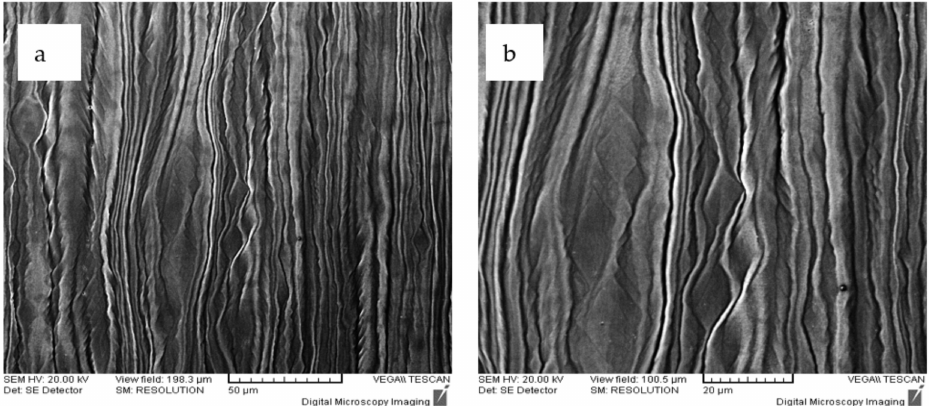
Figure 8. SEM microstructure of the Ti29.3Nb13.6Zr1.9Fe alloy processed at two ( a , b ) differ- ent magnifications.